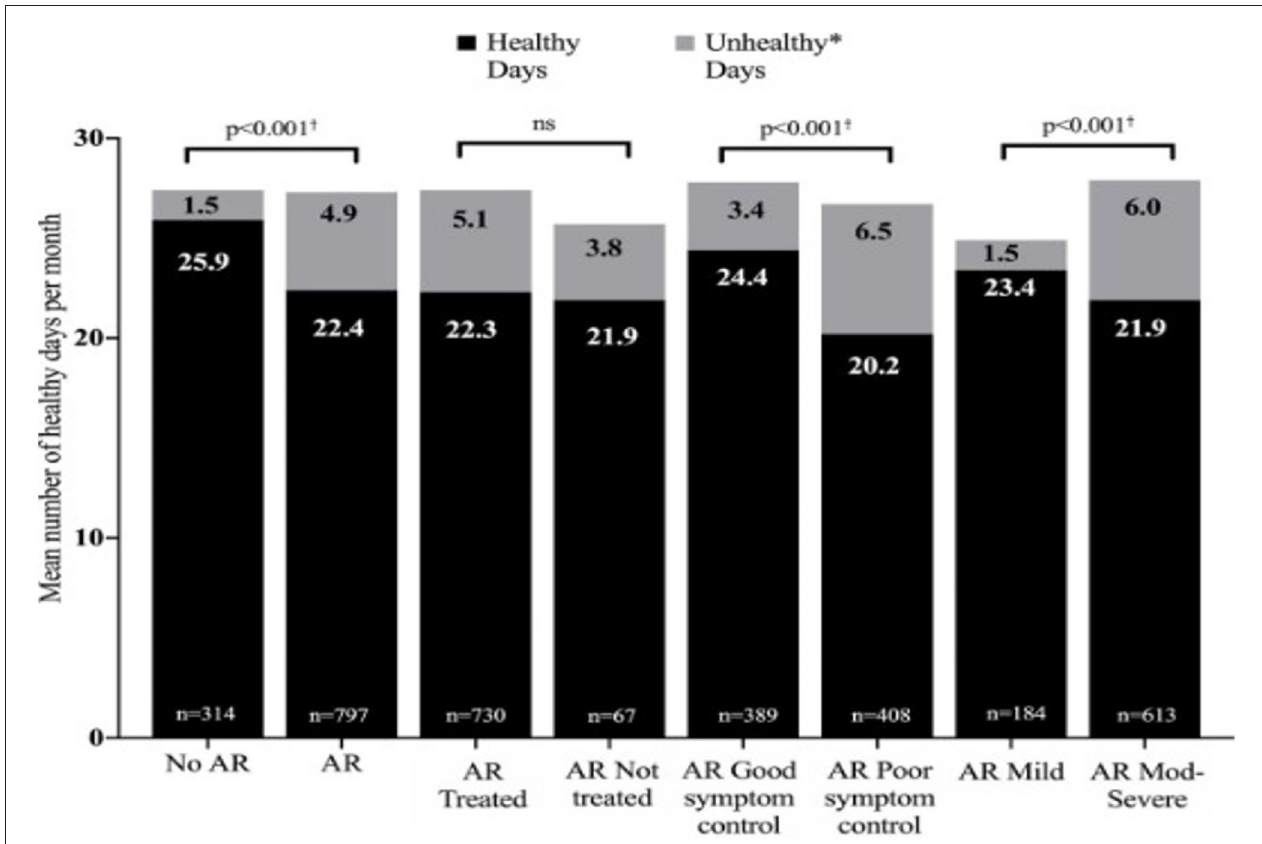
FIGURE 1 | The burden of allergic rhinitis in children aged 6–15 years. Moderate to severe rhinitis and poor symptom control cause over 6 unhealthy days per month. Reproduced from Bosnic-Anticevich S et al. Impact of allergic rhinitis on the day-to-day lives of children: insights from an Australian cross-sectional study. BMJ Open. (2020) 10:e038870. doi: 10.1136/bmjopen-2020-038870, with permission. *Unhealthy days = number of days of poor emotional health and number of days of poor † physical health combined. Statistically significant difference between groups for each metric (healthy days and unhealthy